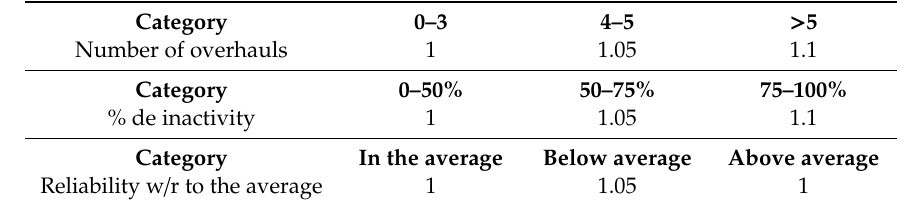
Table 8. Reliability